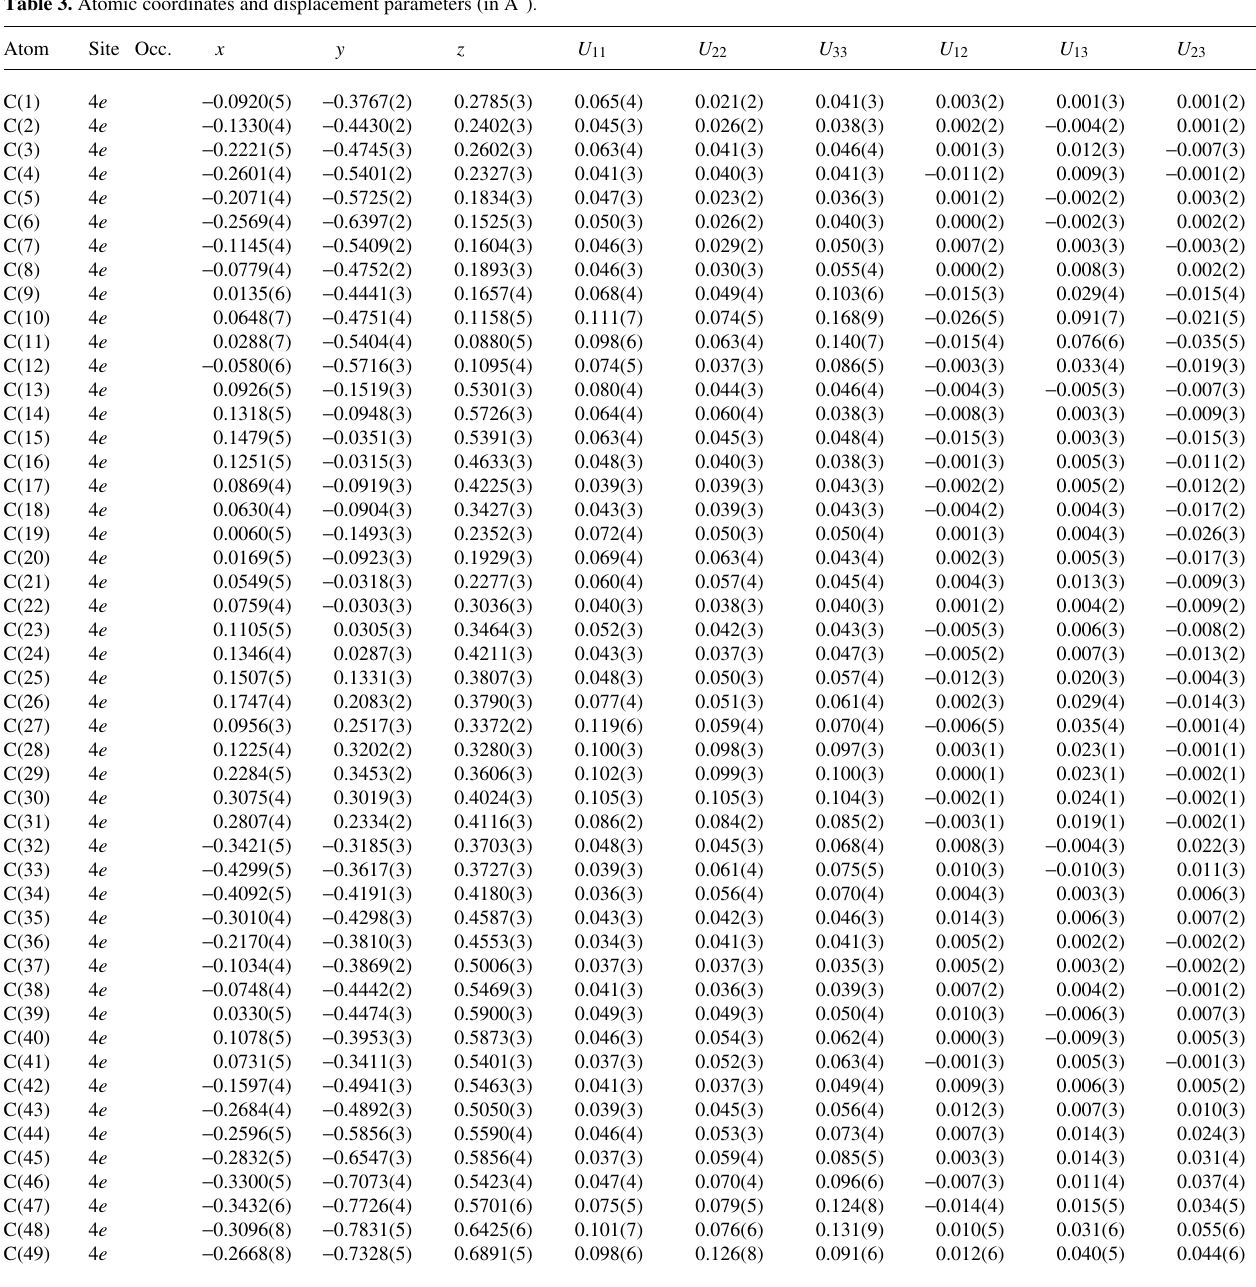
Table 3. Atomic coordinates and displacement parameters (in Å 2 ) .